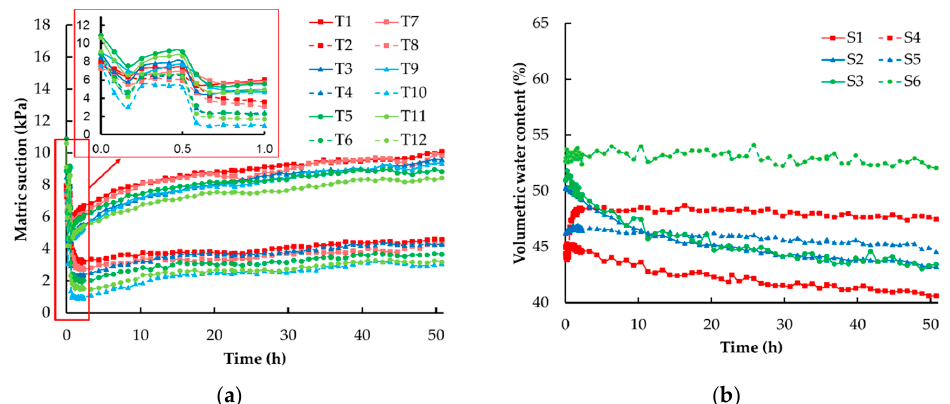
Figure 13. Parameters graphs monitored during the redistribution phase in a sloping deposit: ( a ) suction; and ( b ) volumetric water